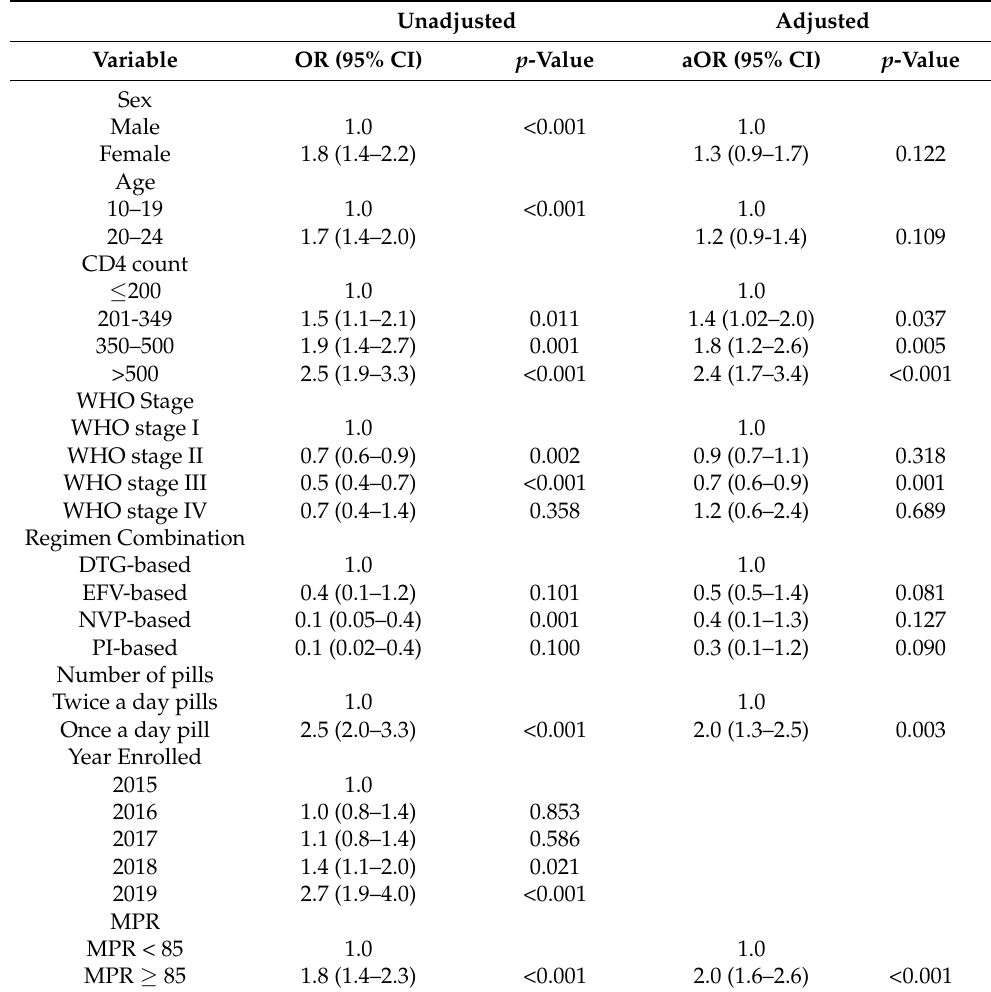
Table 3. Factors associated with virological suppression ( n =